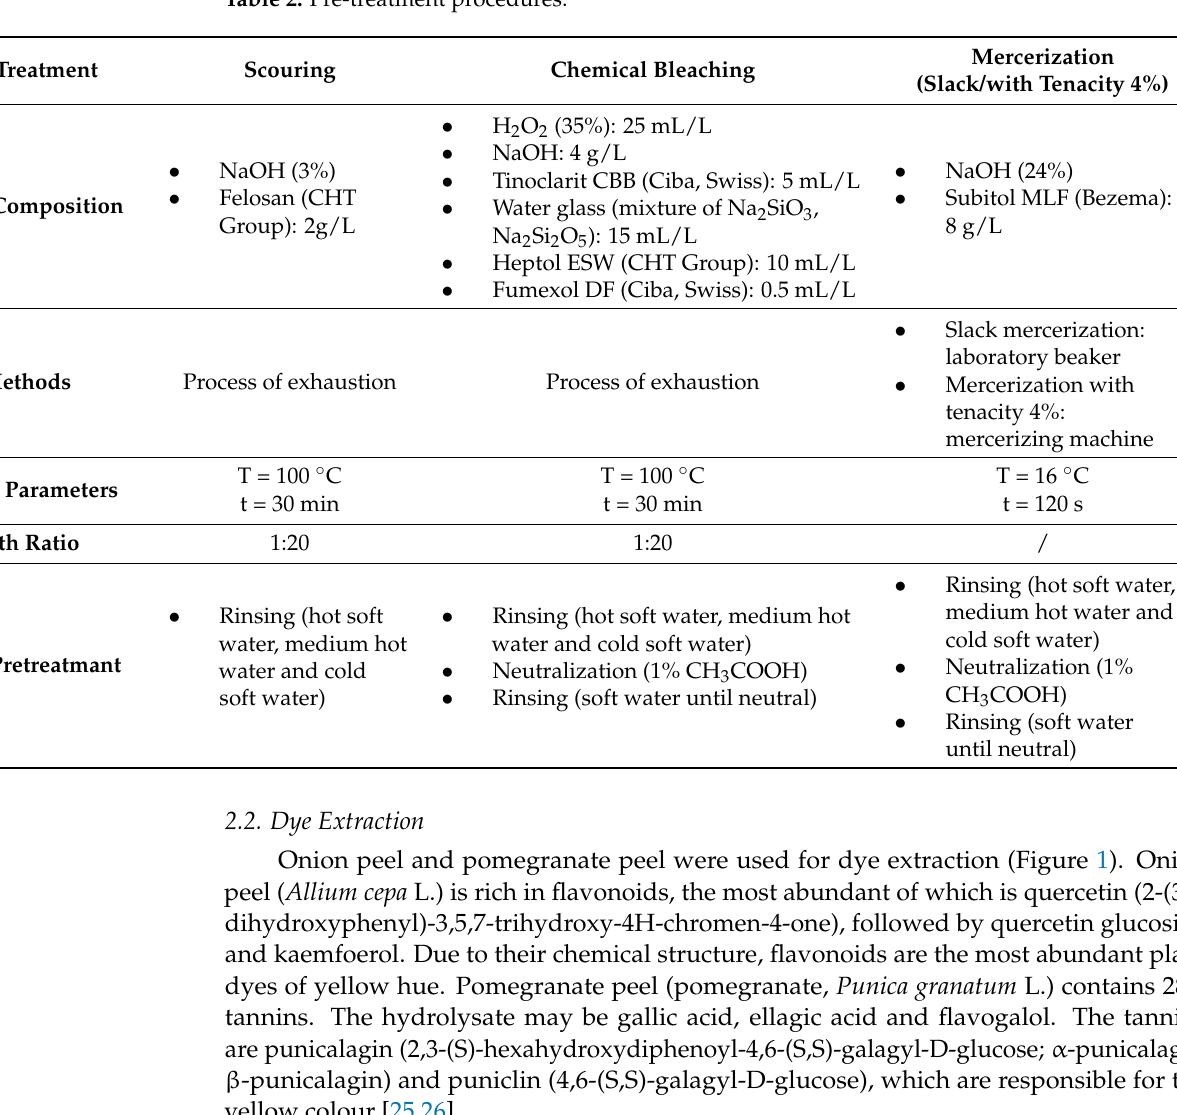
Table 2. Pre-treatment procedures.